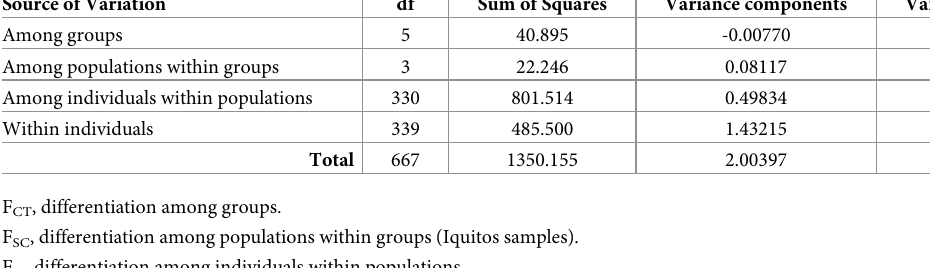
Table 4. Analysis of Molecular Variance (AMOVA) of Ae . aegypti mosquitoes using 8 microsatellite loci. Source of Variation df Sum of